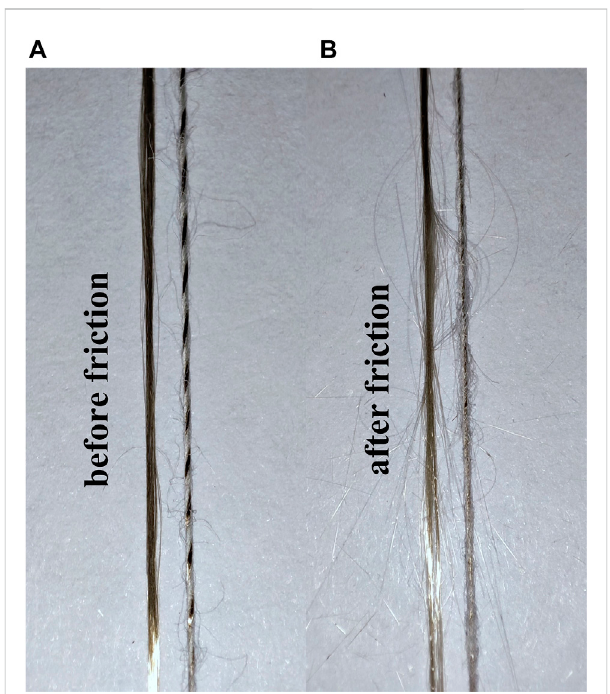
FIGURE 8 Friction performances comparison between pure basalt fi lament and low-torque composite yarn: (A) apparent structure of basalt fi lament and low-torque composite yarn before friction ang (B) apparent structure of basalt fi lament and low-torque composite yarn after